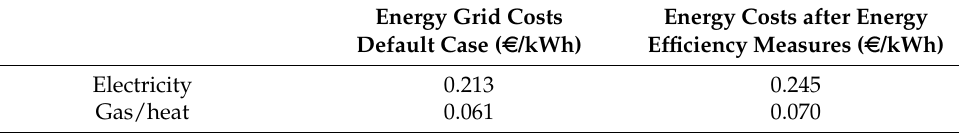
Table 7. Grid energy costs and local energy costs with energy efficiency